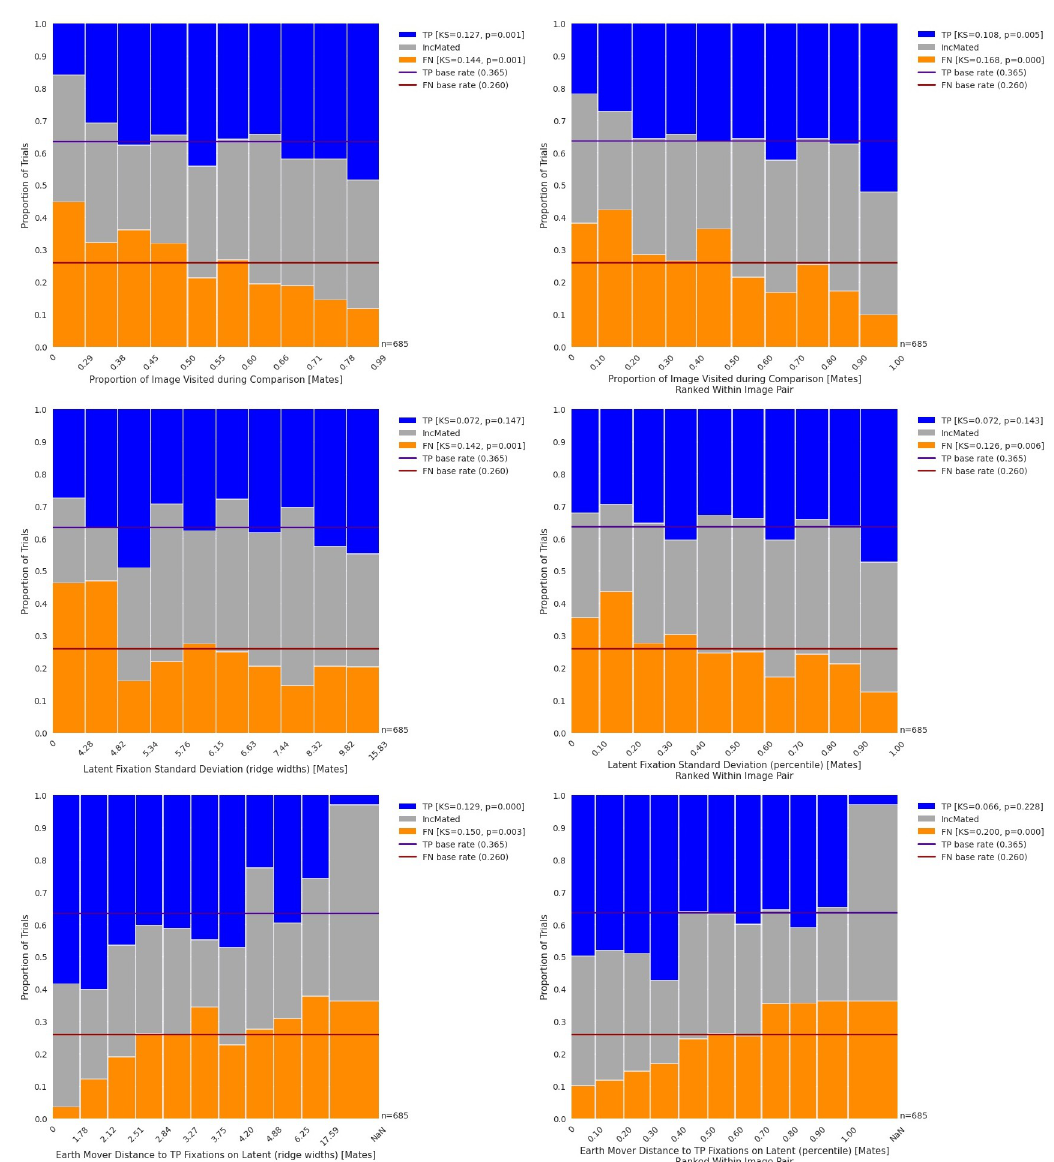
Fig 9. Column plots for three measures of the spatial distribution of fixations. Upper-left panel: Proportion of image visited. Upper-right panel: Proportion of image visited ranked within image pairs. Both graphs show a strong association between TP outcomes and proportion of image visited. Middle-left panel: Latent Fixation Standard Deviation. Middle-right panel: Latent fixation standard deviation, ranked within image pairs. Lower-left panel: Earth Mover Distance to TP Fixations; NaN values come from image pairs with fewer than two TP outcomes. Lower-right panel: Earth Mover Distances to TP ranked within image pair.